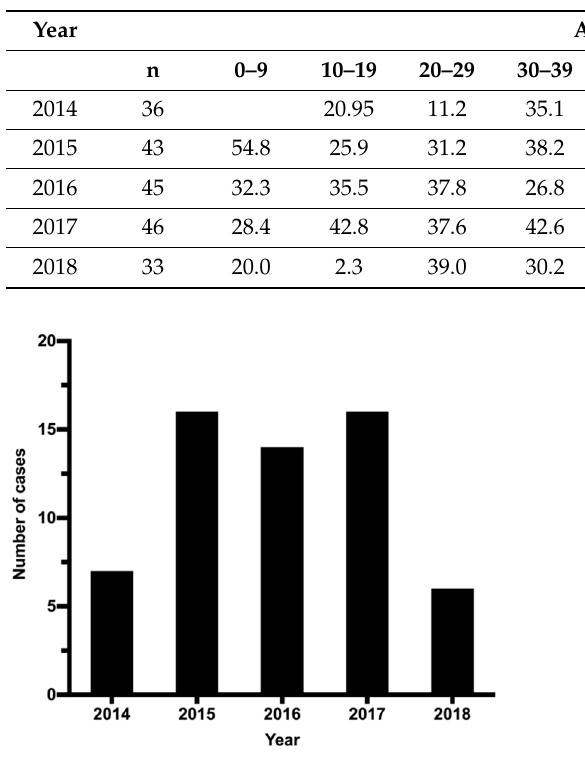
Figure 1. CO poisoning fatal cases (n = 59) in Kuwait (2014–2018). Table 2. COHb% in blood specimens of CO poisoning fatal cases (n = 59) in Kuwait . Year n